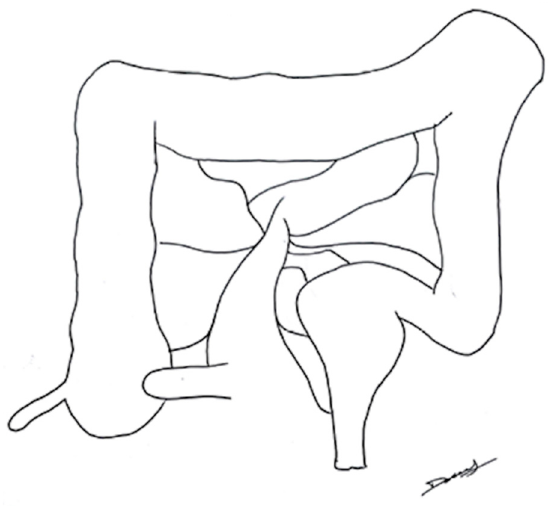
Figure 2. A simplified design of the colon.